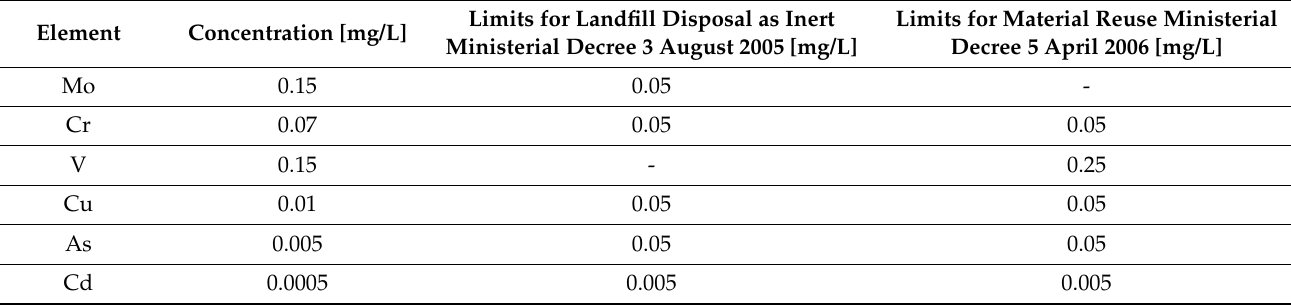
Table 2. Leaching test results of EAF slag with grain size less than 4